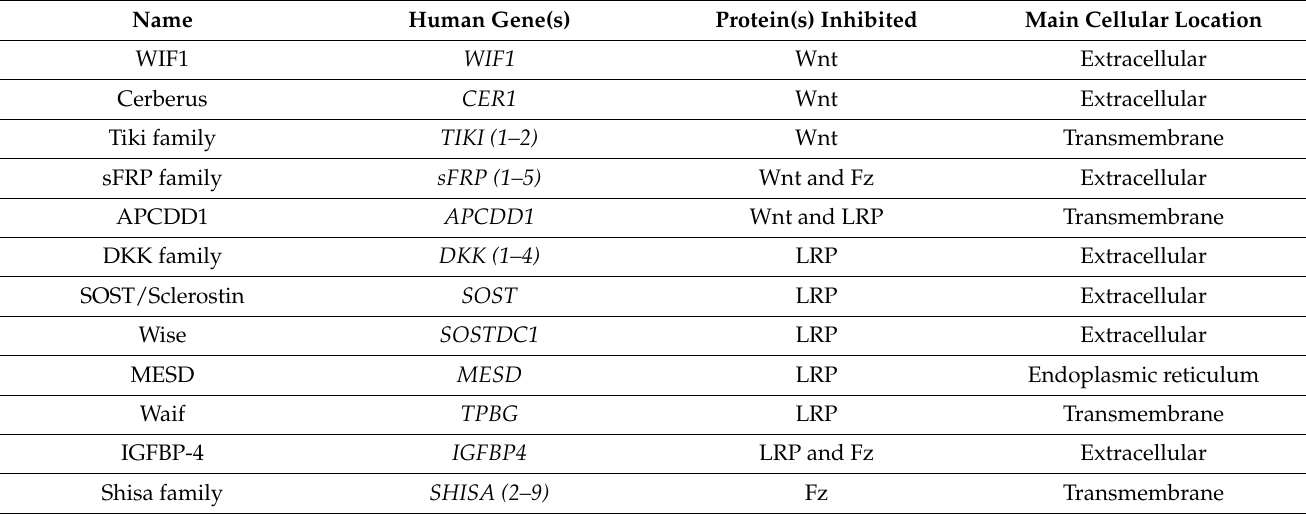
Table 1. Antagonist proteins of the Wnt signaling